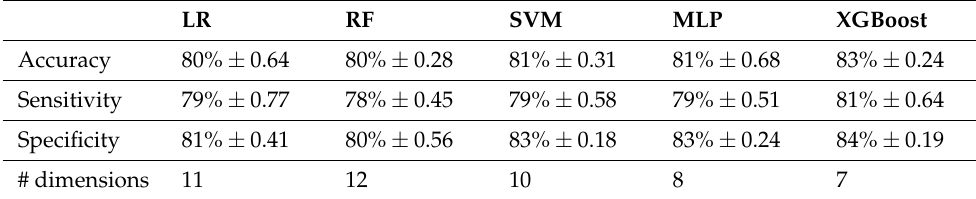
Table 3. Quantitative evaluation of the first stage of our system when PCA method is the feature reduction scheme. The values are average accuracy ± standard deviation.